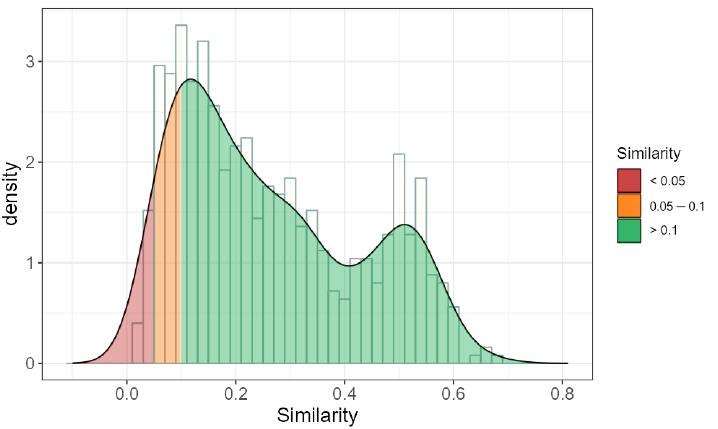
Figure 13. Similarity of spokes after transformation. The x-axis represents the reciprocal of the av- erage distance between points in the same location, and the y-axis represents the data density. The larger the value, the more similar the shape. The green area is the number of samples with an aver- age distance of less than 20 px, and the similarity of the detection results in this area was high.